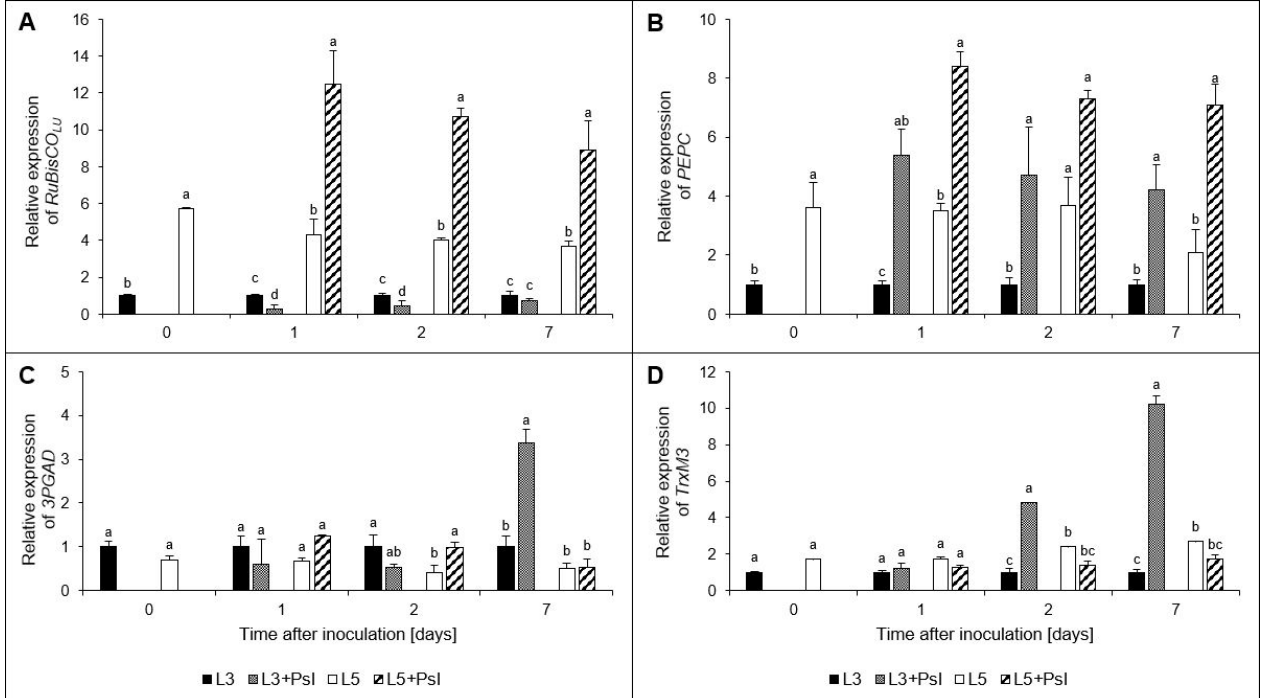
Figure 7. Relative expression of genes in cucumber leaves after Psl infection: ( A ) ribulose-1,5- bisphosphate carboxylase/oxygenase large unit ( RuBisCO LU ), ( B ) phosphoenolpyruvate carboxylase ( PEPC ), ( C ) chloroplast glyceraldehyde 3-phosphate dehydrogenase ( 3PGAD ), and ( D ) chloroplast thioredoxin M3 ( TrxM3 ). Values are means of four replicates (±SD). Different letters (a–d) indicate significant ( p ≤ 0.05) differences between experimental variants at a given time point.